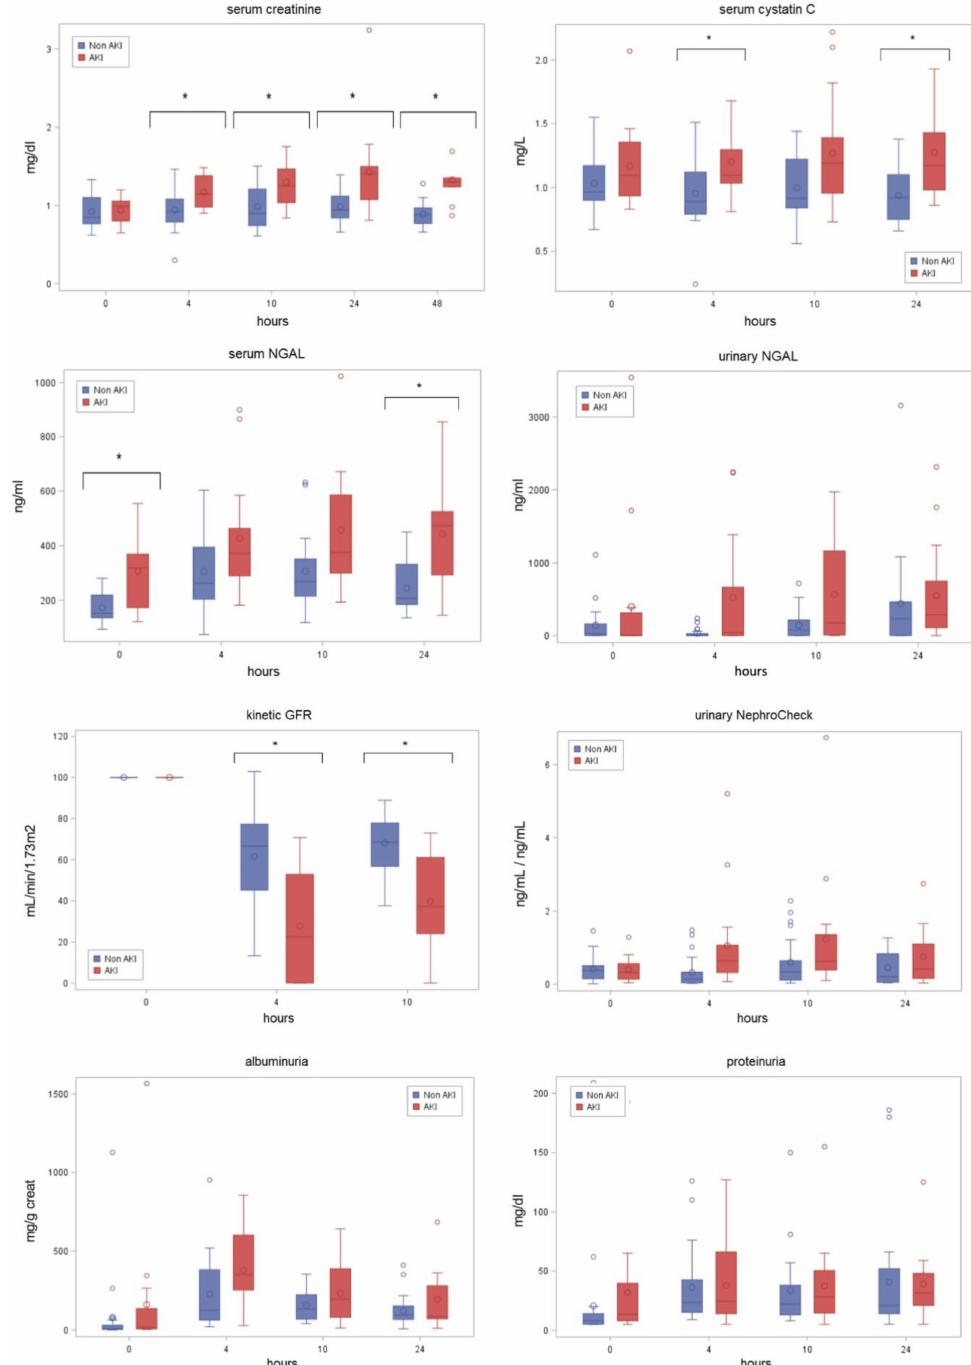
Figure 2. The postoperative change in biomarker levels from baseline to 24 h after surgery. Different graphs summarize the pattern of post-operative changes of the studied biomarkers as well as serum creatinine, both in patients who experienced AKI (red) and non-AKI (blue) Asterisk indicates p < 0.05. AKI; Acute Kidney Injury. Serum creatinine is expressed in mg/dL, serum cystatin C in mg/L, serum and urinary NGAL (neutrophil gelatinase-associated lipocalin) in ng/mL, kinetic GFR (glomerular filtration ratio) in mL/min/1.73 m 2 , Nephrocheck TM is the ratio between TIMP-2 (tissue inhibitor of metalloproteinase-2) in ng/mL and IGFBP7 (insulin-like growth factor binding protein 7) in ng/mL and it is expressed as an AKIRISK TM Score ( ≤ 0.3 low-risk of AKI, >0.3 high-risk of AKI), albuminuria is expressed in mg/g, proteinuria is expressed in